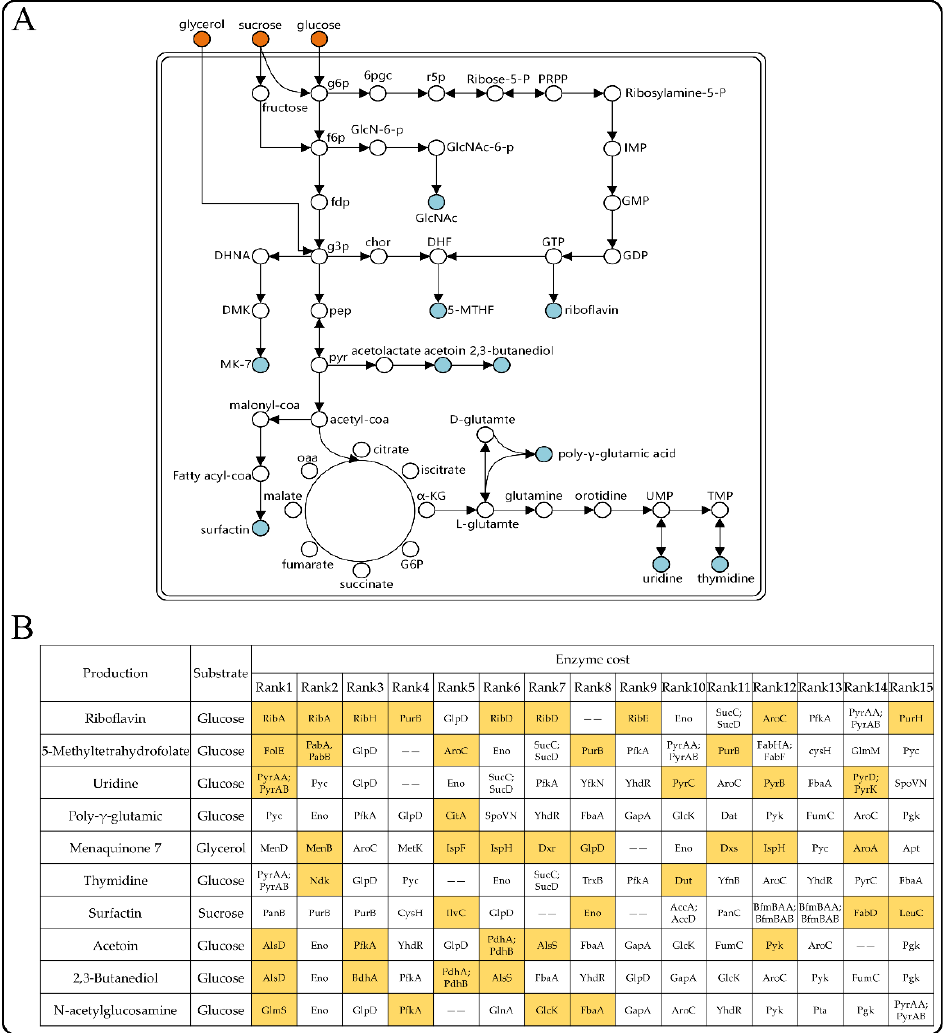
Figure 6. Predicted metabolic engineering targets for improving the synthesis of the indicated products in B. subtilis . ( A ) The synthesis pathways of 10 products in B. subtilis . ( B ) Prediction of targets for the synthesis of the 10 products in B. subtilis using ecBSU1. Targets that have been reported in the literature are marked in yellow, and those that require multiple genes to act together are marked with ‘‘ -- ’’ .